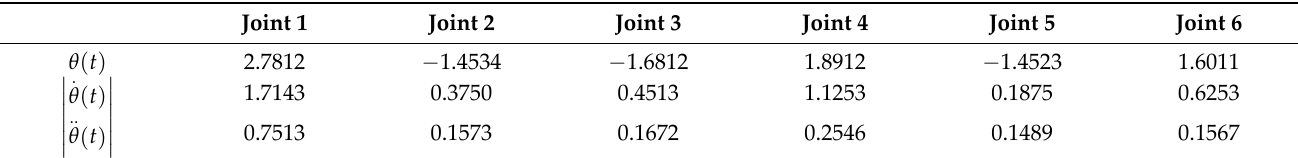
Figure 9. Angular position, angular velocity, and angular acceleration curves of each joint. Table 9. Maximum angular position, angular velocity, and angular acceleration of each joint under optimal time